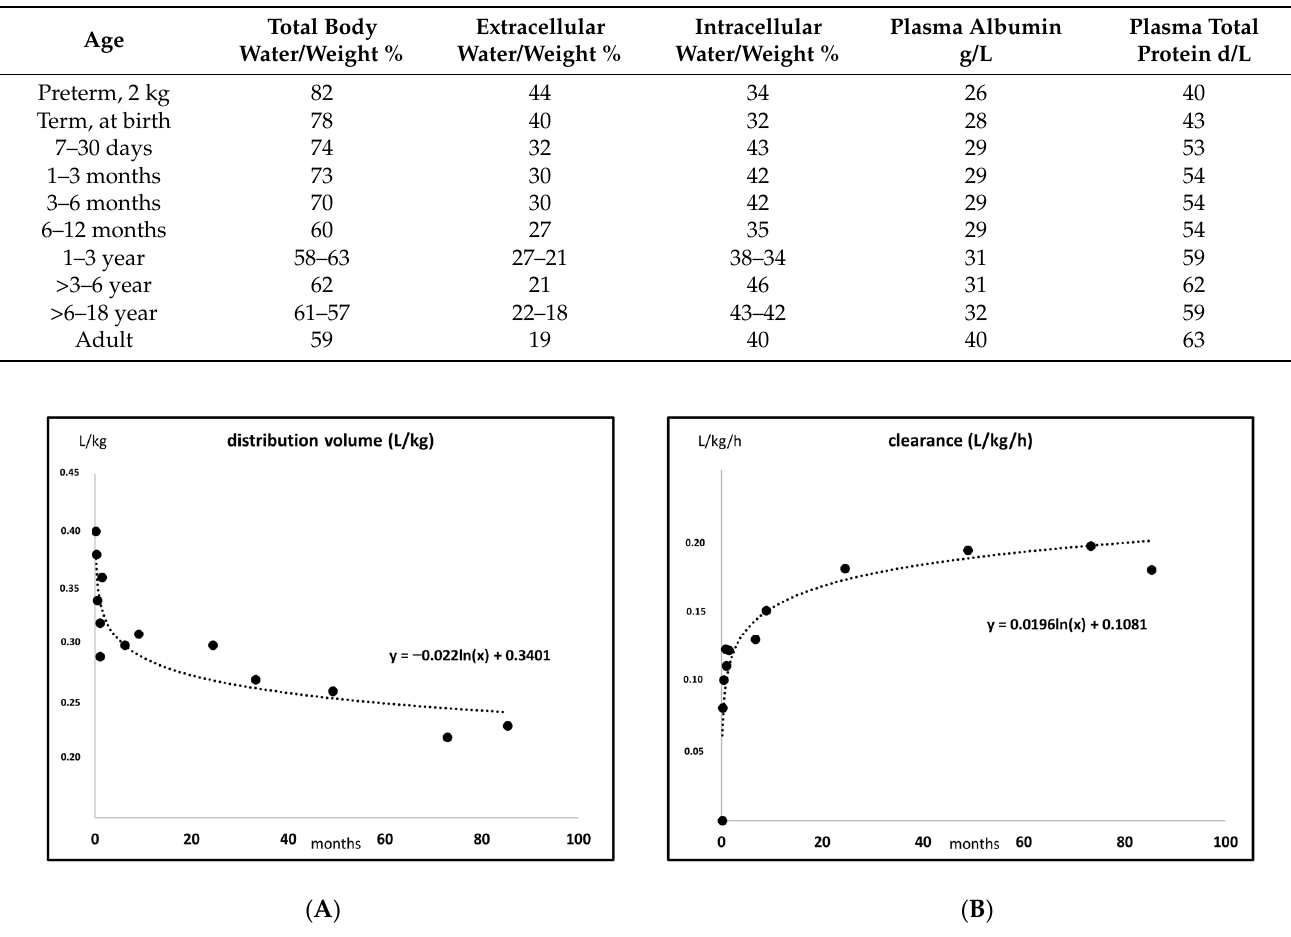
Figure 2. Illustration of maturational changes of ( A ) volume of distribution (Vd, L/kg) and ( B ) clearance (CL, L/kg/h) with the trend lines, based on amikacin pharmacokinetic data in 155 patients (body weight 1.35–33 kg) in the first 85 months of life [28].